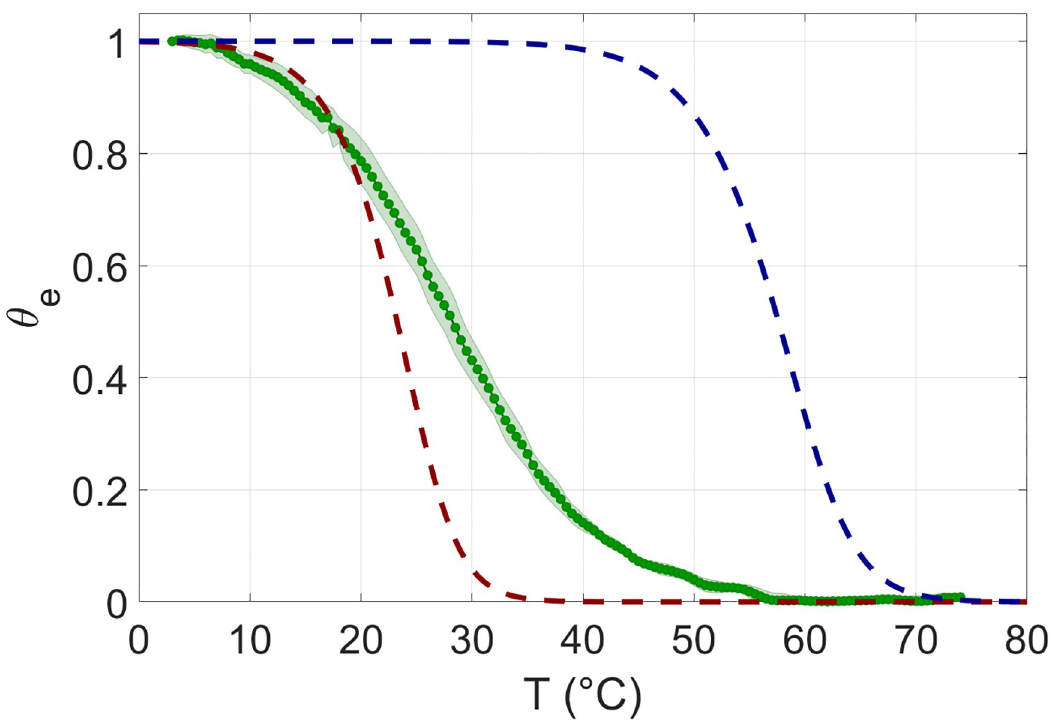
Fig 2. Double strand vs. random sequence DNA melting. Ensemble melting curve as a function of temperature. Green dots: measured ensemble melting of 12N at c = 0.04 g/l. Shading marks experimental uncertainty resulting from the average over 8 rsDNA experimental replicas. Dashed lines: theoretical melting predicted for equimolar solutions of two complementary 12mers at c DNA = 0.02 g/l each (dashed blue line) and c = 0.04/4 12 � 2.4 10 − 9 g/l each (dashed red line). 12N θ ( T ) exhibits a behavior intermediate DNA e between the two. Dashed lines are obtained by averaging many melting curves of complementary 12mers. c NaCl = 1M in all curves.